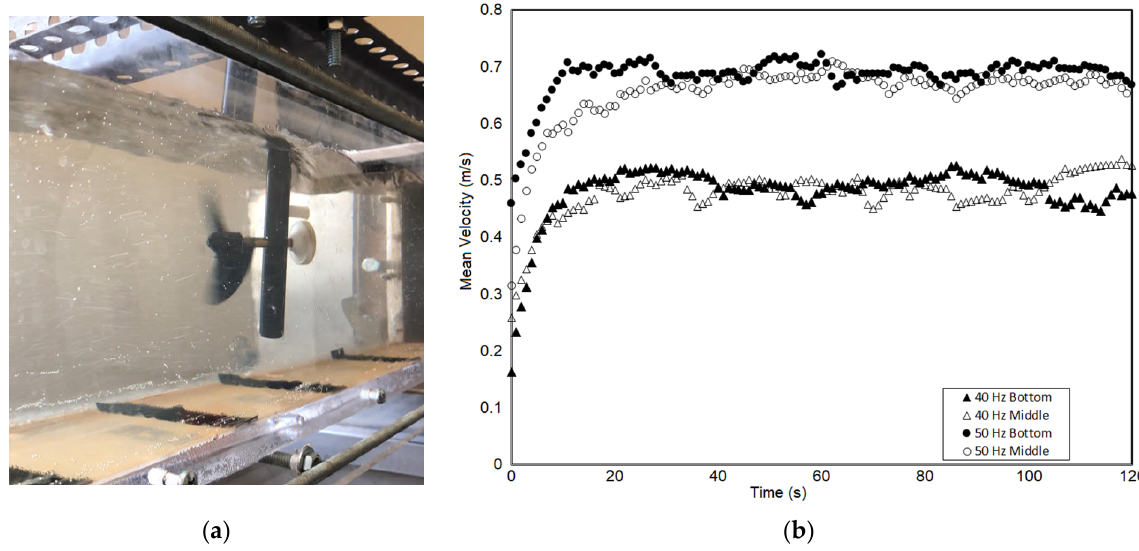
Figure 11. The panel ( b ) displays the velocity reading by Vernier flow meter versus time when the pump operates at 40 and 50 Hz. The propeller is placed either near the floor of the chamber (“Bottom”) or approximately in mid-height (“Middle”). Data suggests minimum difference by the two methods. The panel ( a ) shows the propeller being lowered in the “Middle” position in the observation